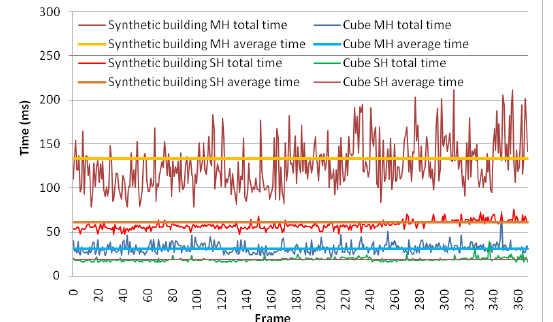
Figure 16. PS computation times using synthetic/real sequences and SH/MH.